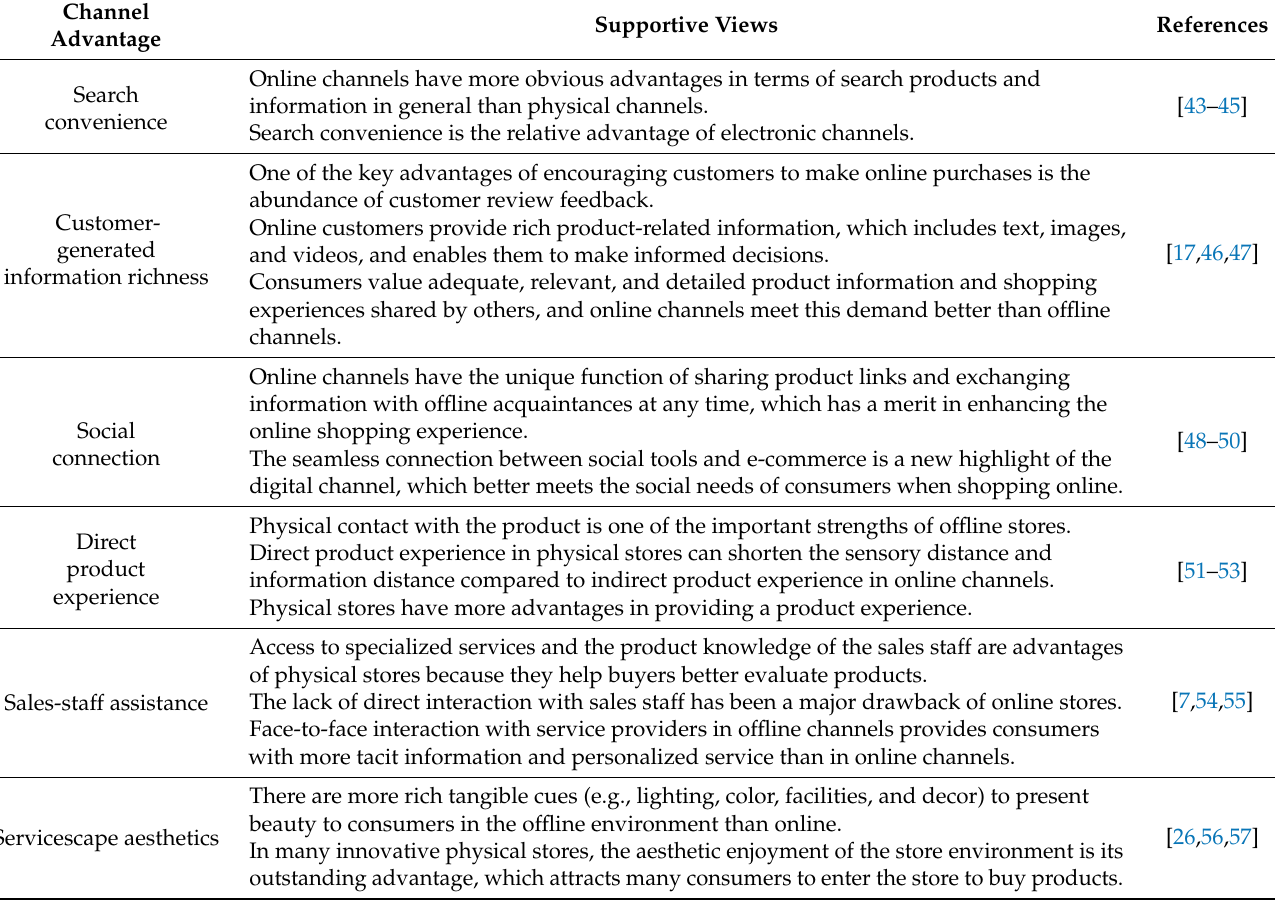
Table 2. Literature